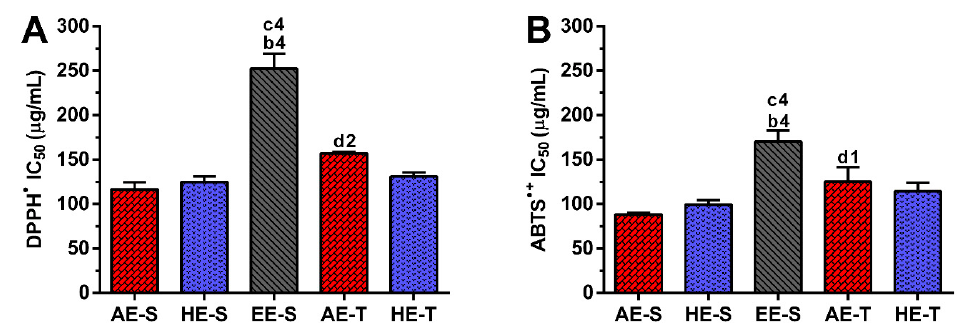
Figure 3. Half-maximal inhibitory concentration (IC 50 , µg/mL) of the different Salvia officinalis